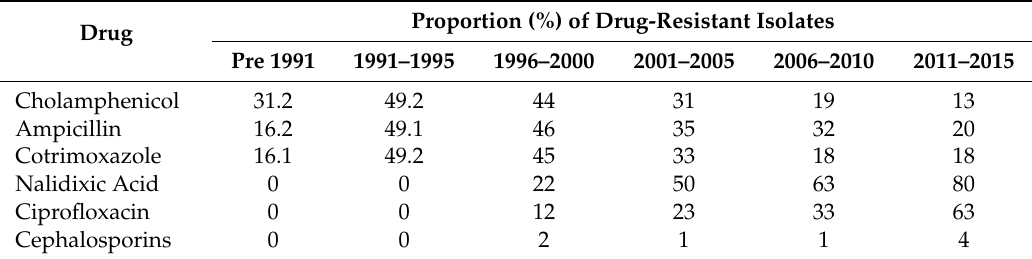
Table 3. Proportion (%) of drug-resistant isolates of Salmonella typhi